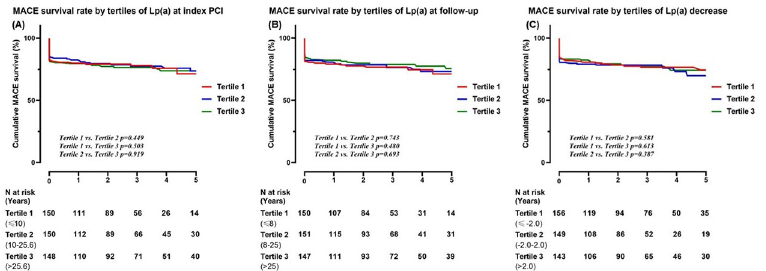
Fig 3. Kaplan-Meier curves of MACE survival rate by tertile of Lp (a) at index PCI (A). Kaplan-Meier curves of MACE survival rate by tertile of Lp (a) at follow-up (B). Kaplan-Meier curves of MACE survival rate by tertile of Lp (a) decrease (C). Lp (a); lipoprotein (a), MACE; major cardiovascular adverse event, PCI; percutaneous coronary